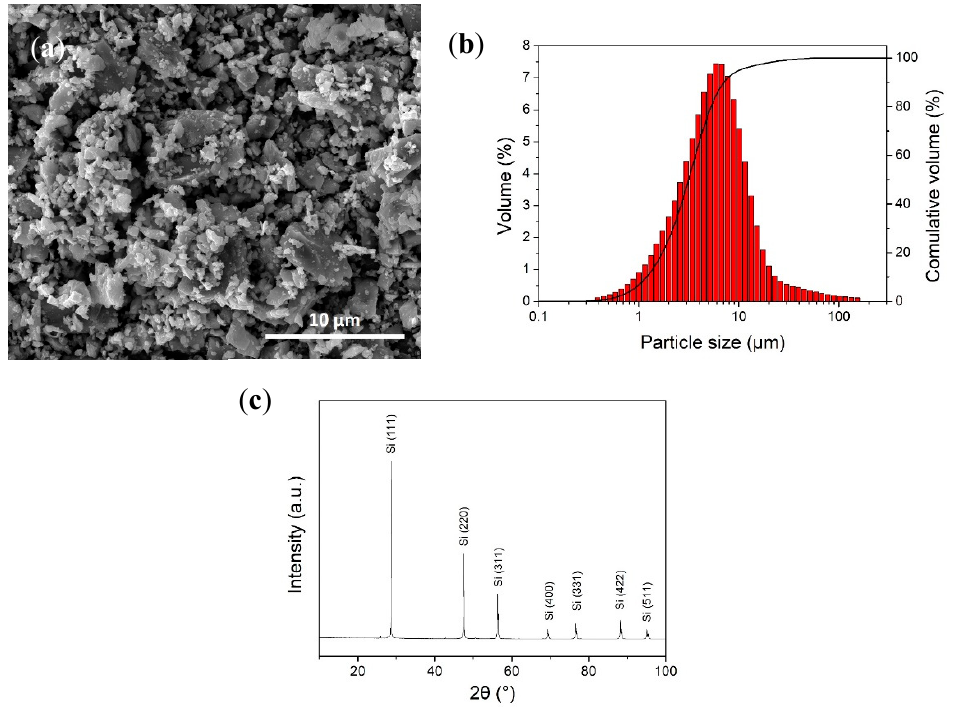
Figure 1. ( a ) SEM image, ( b ) particle size distribution, and ( c ) X-ray diffraction pattern of as-received Si waste powders.